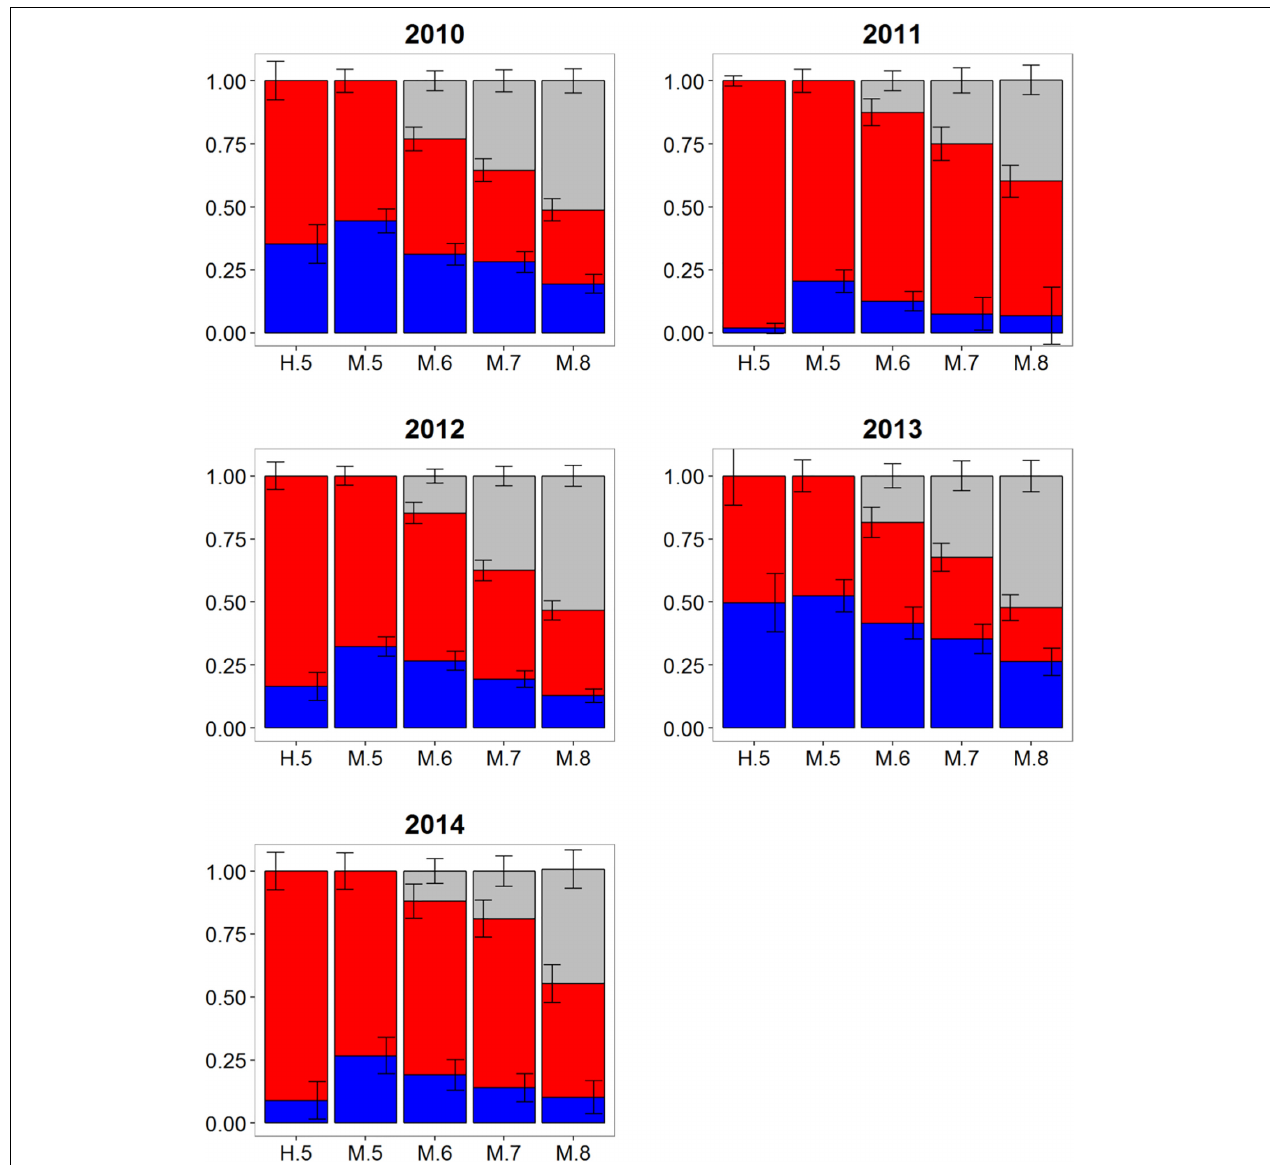
FIGURE 4 | Estimated proportions of western (blue), eastern (red), and undetermined (gray) Atlantic bluefin tuna in samples collected from 2010 to 2014 in the Central North Atlantic Ocean—East of 45 ◦ W. Results are based on mixed-population analysis using HISEA and multinomial logistic regression (MLR) frameworks. H.5 denotes predictions from HISEA while MLR estimates are shown as M.5, M.6, M.7, M.8 to represent the four different probability thresholds (0.5–0.8). Uncertainty around predictions shown with error bars which represent 1 ± SD around estimated